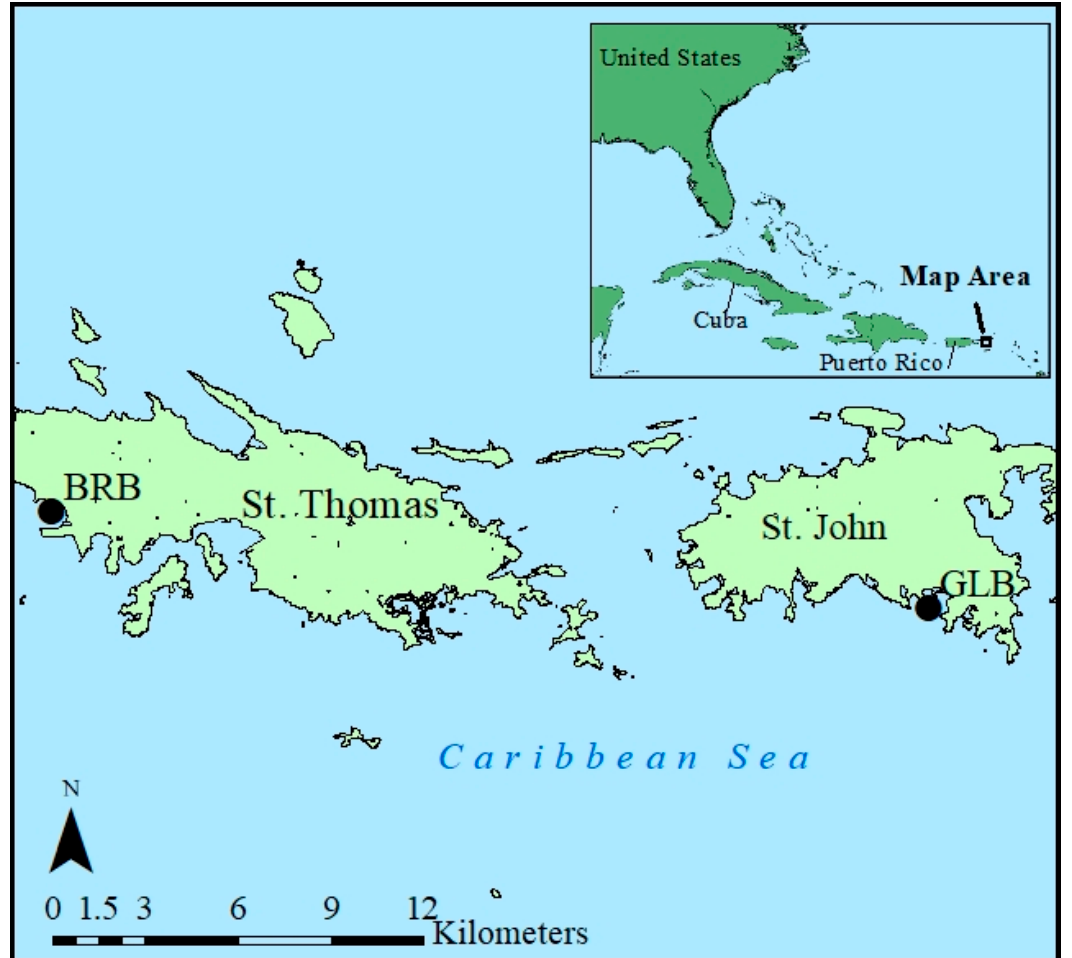
Figure 1. Location of study sites Brewers Bay (BRB) and Greater Lameshur Bay (GLB) where host fish and parasites were collected.